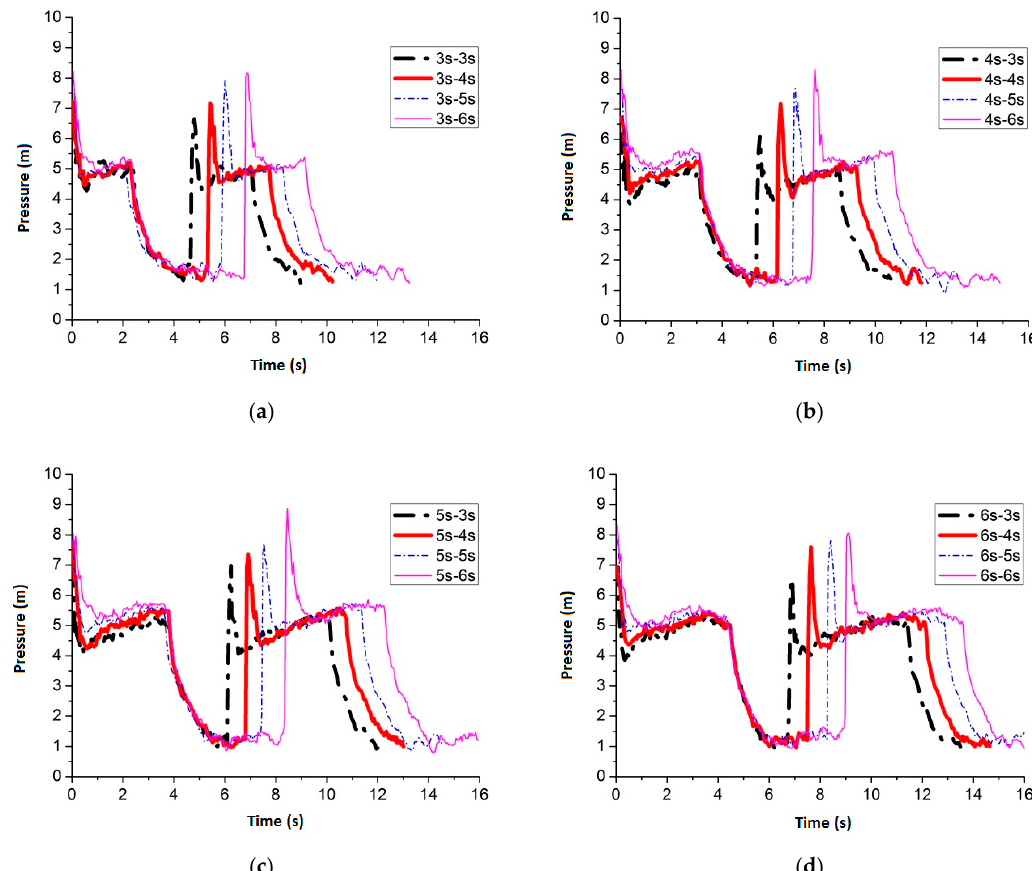
Figure 6. Pressure fluctuation of No. 1 sensing point (round nozzle on top of the pipe): ( a ) air inflow time is 3 s; ( b ) air inflow time is 4 s; ( c ) air inflow time is 5 s; and ( d ) air inflow time is 6 s.